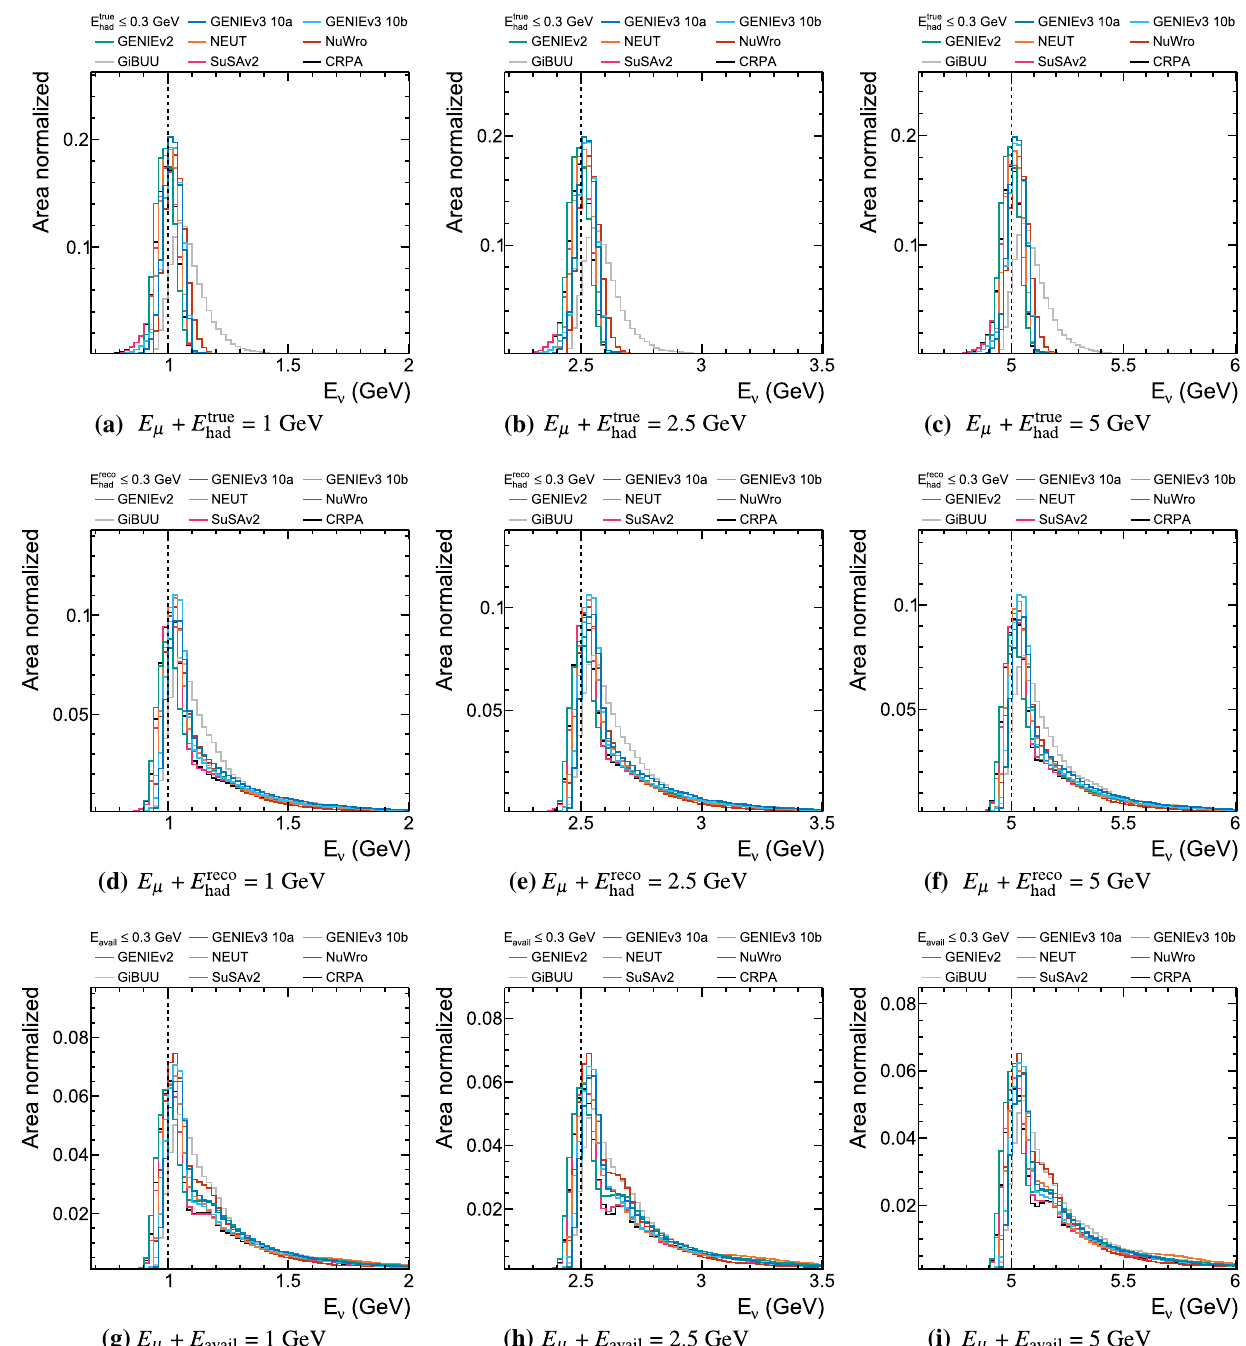
Fig. 10 Area normalized distributions of E true ν corresponding to fixed values of the three proxy E reco ν variables, E μ + E true E avail , at 1, 2.5 and 5 GeV, shown for ν μ – 40 Ar events, for all generator models of interest. A cut on the relevant q 0 proxy of ≤ 0.3 GeV is made in each